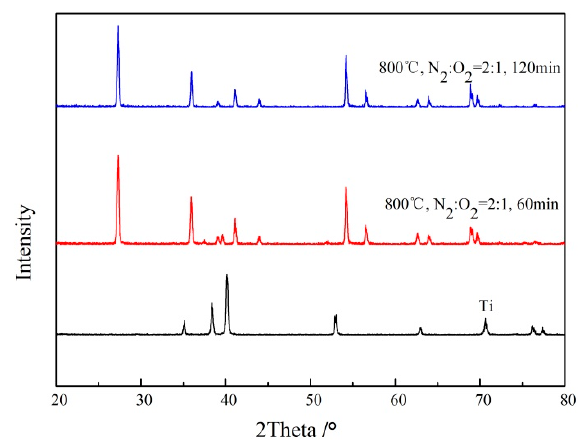
Figure 11. XRD pattern of Ti support after oxidation at different temperatures (800 °C, N 2 :O 2 = 2:1).